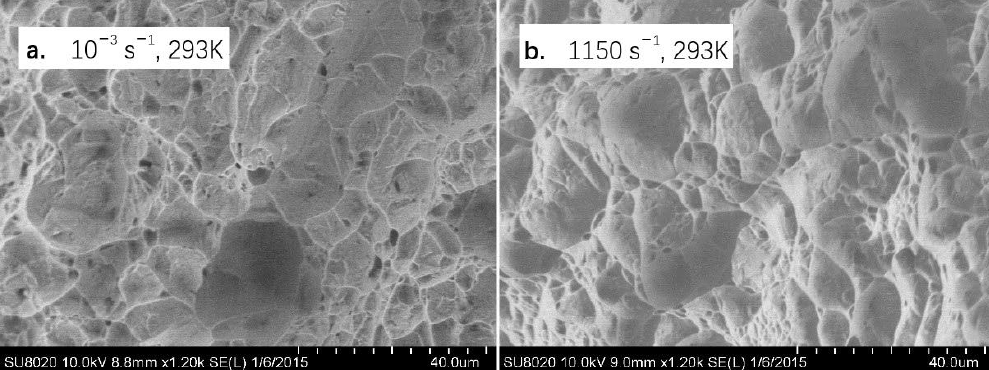
Figure 8. The dimple characteristics at ( a ) 10 − 3 s − 1 , ( b ) 1150 s − 1 .